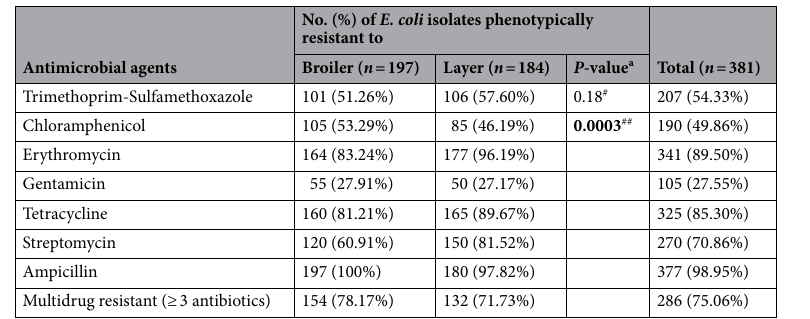
Table 3. Antimicrobial resistance rates among the investigated E. coli ( n = 381) isolates in relation to type of hens (broiler or layer) in Sylhet division of Bangladesh. a P values were calculated using a two-way analysis of variance (ANOVA) without replication. P values < 0.05 are highlighted in bold. # Variance between broiler and layer chickens. ## Variance among the antimicrobial